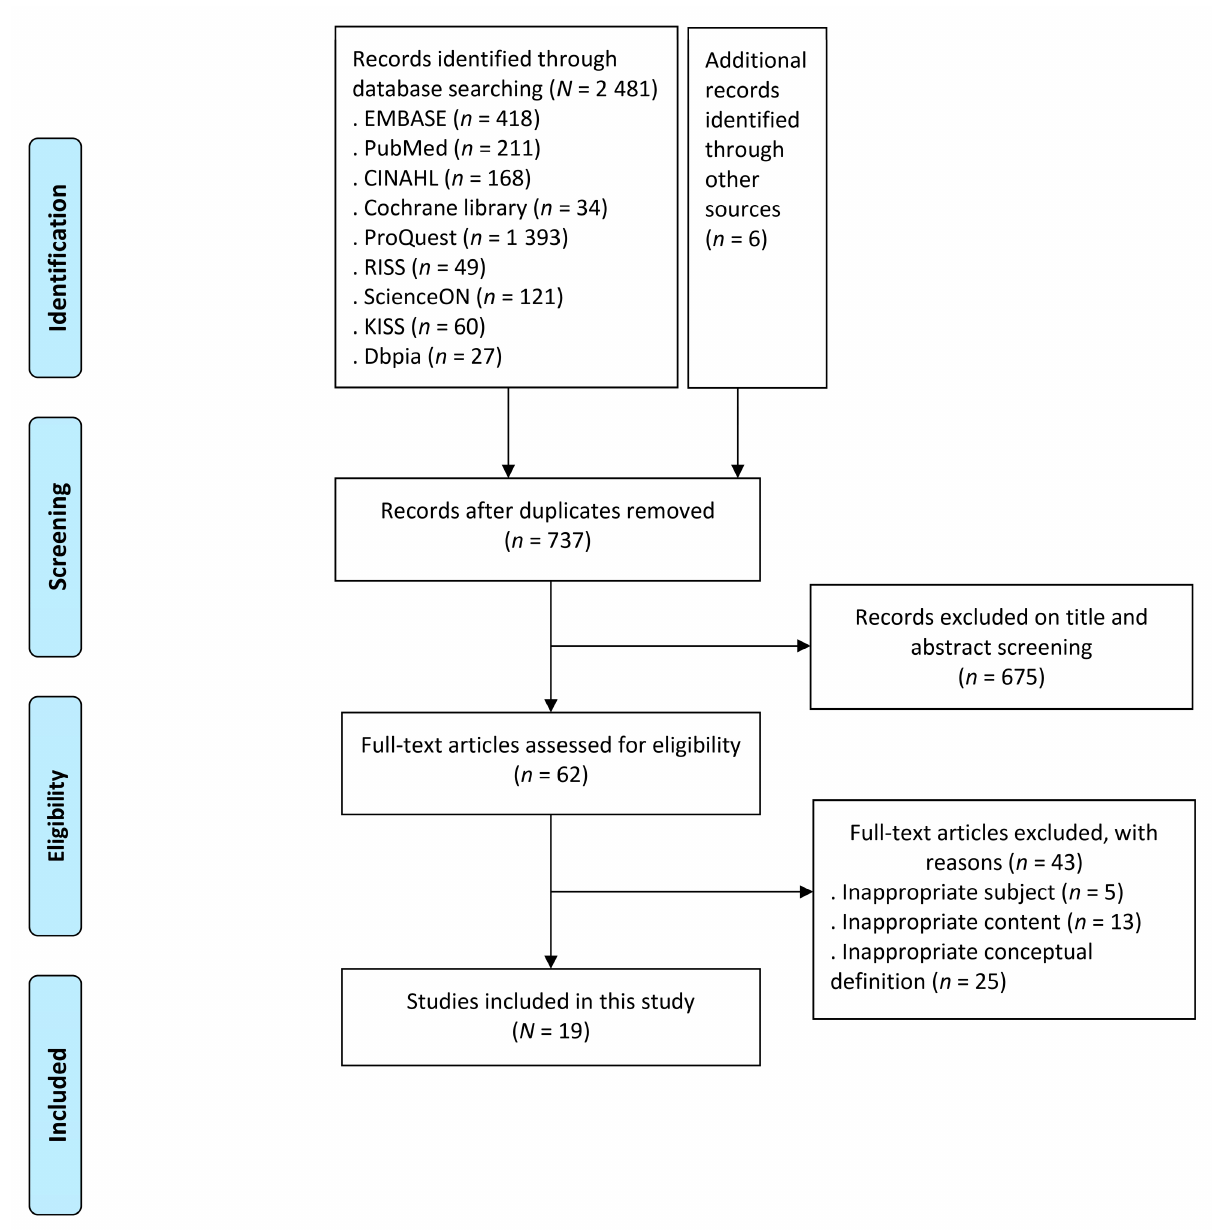
Figure 1. Flow diagram of study selection